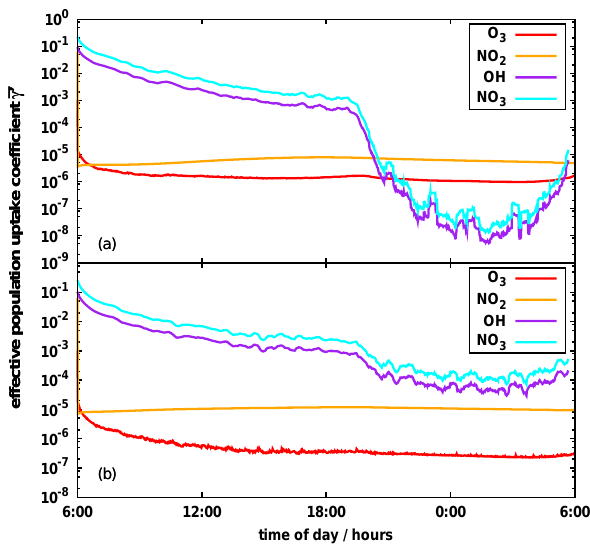
Fig. 5. Evolution of effective uptake coefficients averaged over the whole particle population at each time step during the simulated 24h period. Panels (a) and (b) represent scenarios A and D, respec-